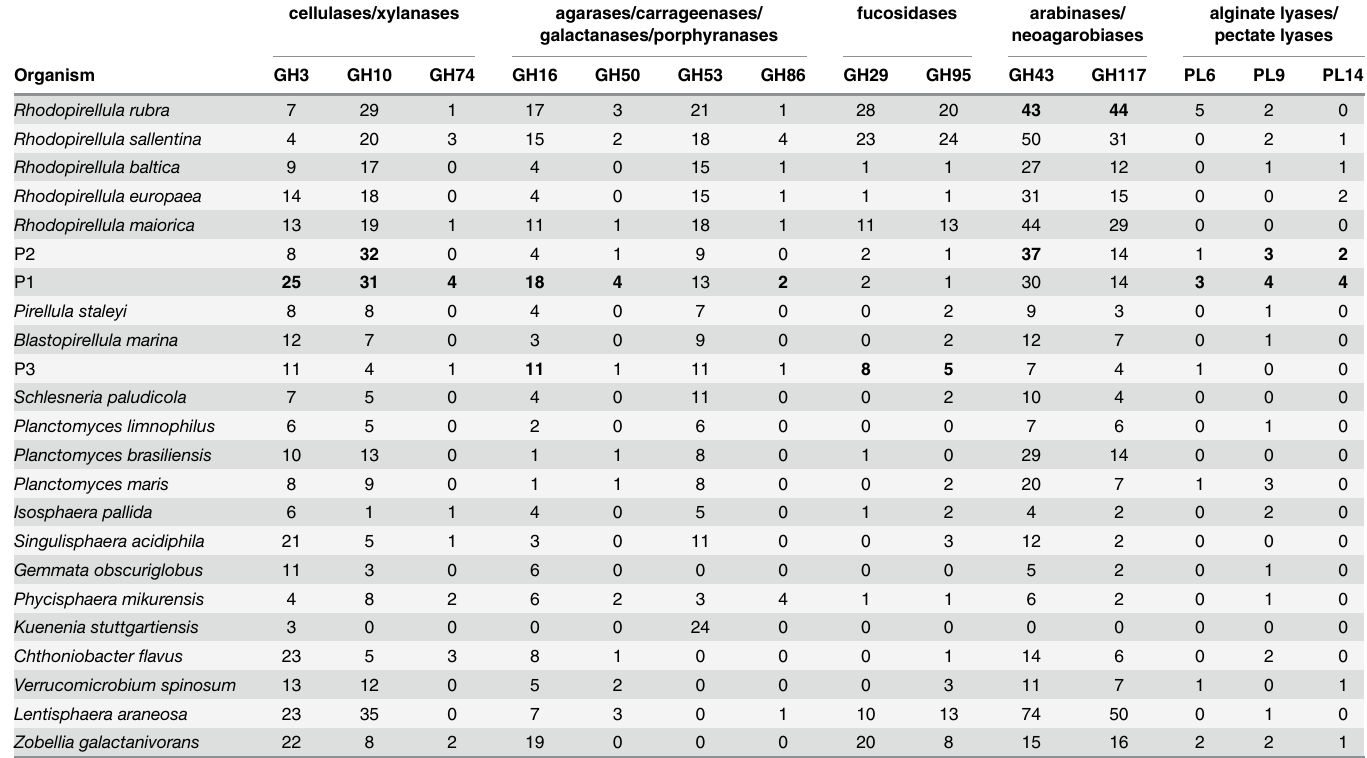
Table 2. Cell wall degradation enzymes in planctomycetes and related species. The number of BLASTp hits (e-value < 1e-10) is shown for selected GH and PL domains, which are involved in the degradation of algal, fungal, and vascular plant cell walls. The rows are ordered according to the phylogeny in Fig 1. Entries for P1, P2 and P3 are bolded in cases where the number of members within a CAZY category has a percent rank among all shown species that is greater than 75%.